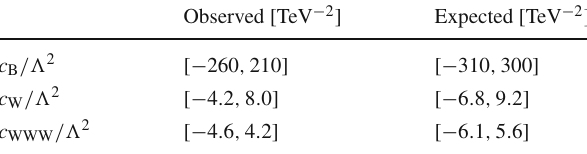
Table 9 One-dimensional limits on the EFT parameters at a 95% CL for WZ → (cid:5)ν(cid:5) (cid:5) (cid:5) (cid:5)